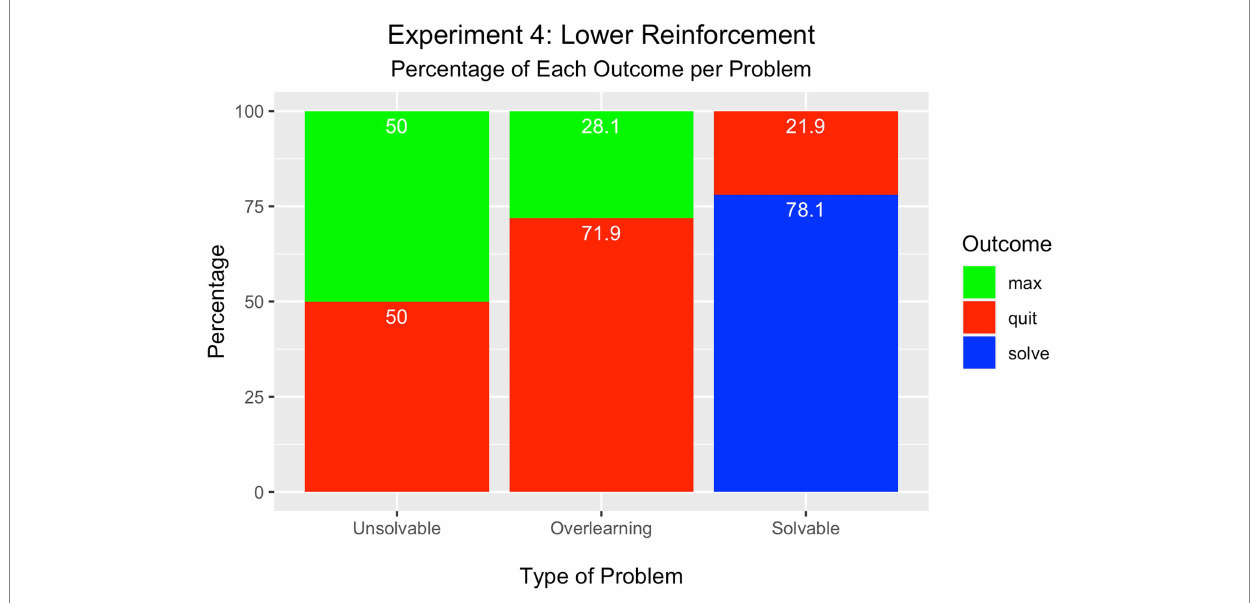
FIGURE 5 Experiment 4 – Lower Reinforcement